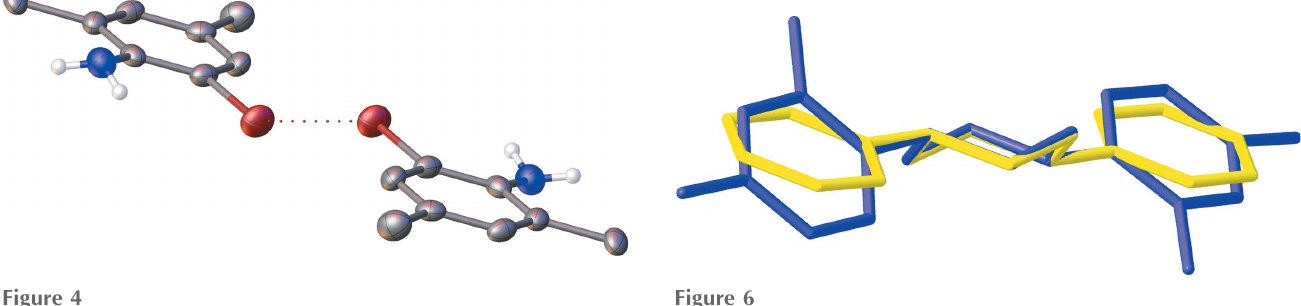
Figure 6 Structure of compound 2 overlaid with N , N 0 -diphenylpiperazine (CCDC refcode